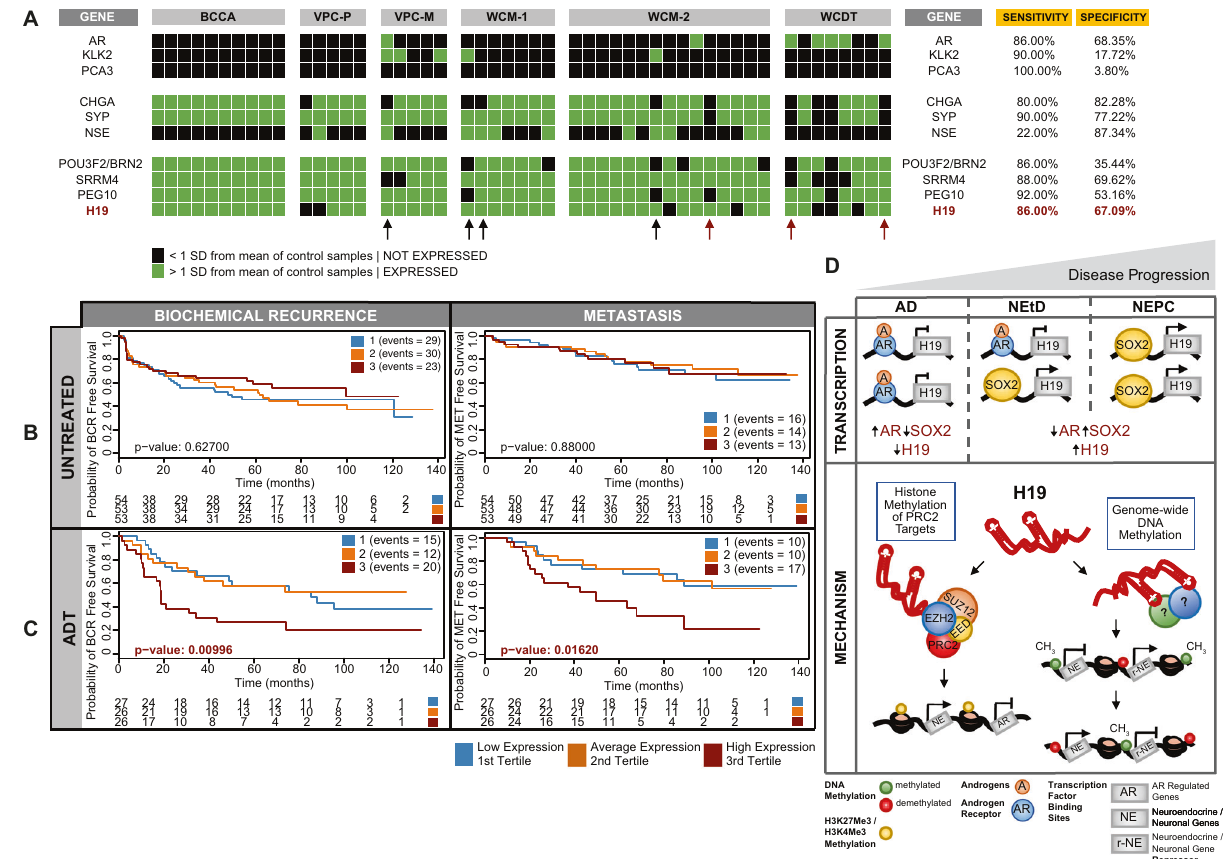
Fig. 9 Diagnostic and predictive ability of H19. A Assessment of sensitivity and speci fi city of H19 in NEPC for use as a diagnostic along with other recently identi fi ed NEPC oncogenes (BRN2, SRRM4, and PEG10). Arrows denote patients that are negative for CHGA (black) or CHGA, SYP, and NSE (red) yet positive for H19 . B , C , Kaplan – Meir estimates for the impact of H19 on prostate cancer clinical outcomes. B Survival analysis for H19 in ADT untreated patients and C ADT treated patients for biochemical recurrence (BCR — left panels) and metastasis (MET — right panels). Samples were split by H19 tertile expression to test if either of these subgroups of patients were more likely to develop BCR and MET in the context of treatment. P values were calculated using a Kaplan – Meier estimator statistical test to determine signi fi cance for the observed strati fi cation in probabilities across the three subgroups in each panel. D , Illustration of H19 transcription and mechanism of action during PCa, NEtD, and tNEPC. During early stage disease, adenocarcinoma cancer cells are driven by an active AR bound to androgens that prevent the transcription of H19 . As the disease progresses (gray triangle), ADTs suppress AR activity, SOX2 increases, and results in the persistent transcription, expression, and activation of H19 . Once active, H19 operates via dual epigenetic mechanisms; (on the left) binds PRC2 complex members, aiding in altering methylation on H3K4Me3/H3K27Me3 histone marks of PRC2 target genes and (on the right) genome-wide alteration of methylation at CpG sites on DNA. Collectively, these epigenetic changes result in the activation of NE gene expression and deactivation of AR signaling gene